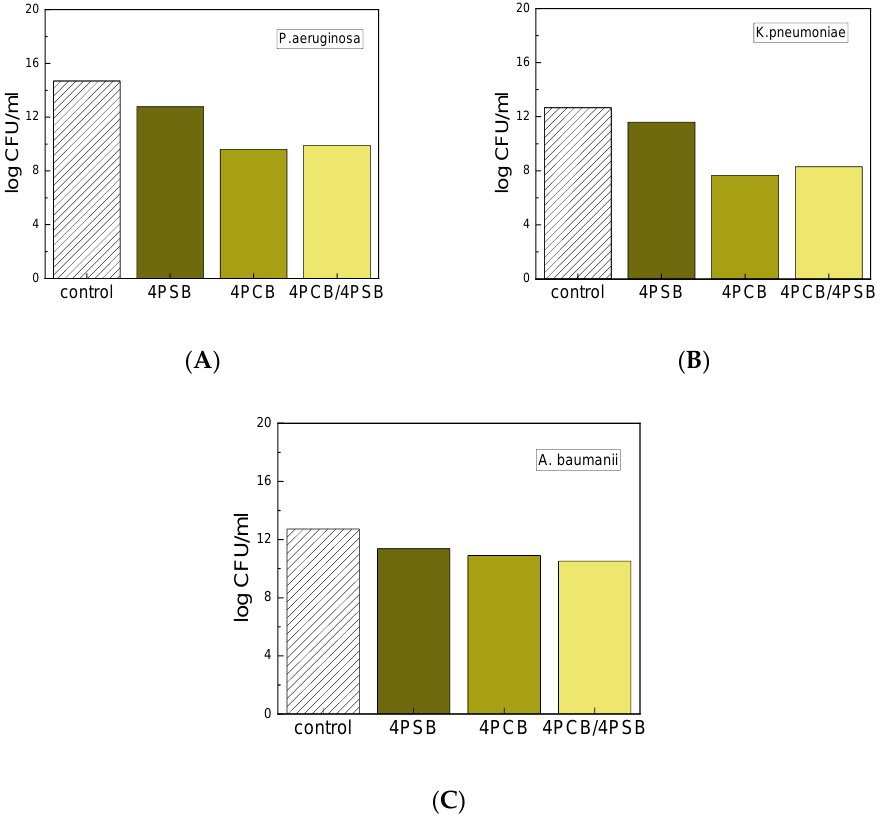
Figure 6. Growth inhibitory activity of 4PSB, 4PCB and PCB/PSB IPN hydrogels towards ( A ) P. Aeruginosa, ( B ) K. Pneumoniae and ( C ) A. Baumanii.